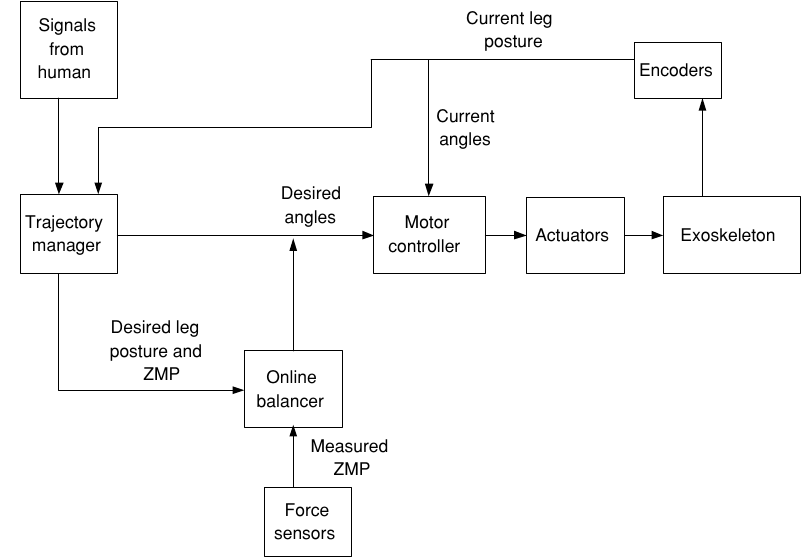
Figure 26 Exoskeleton signal flow